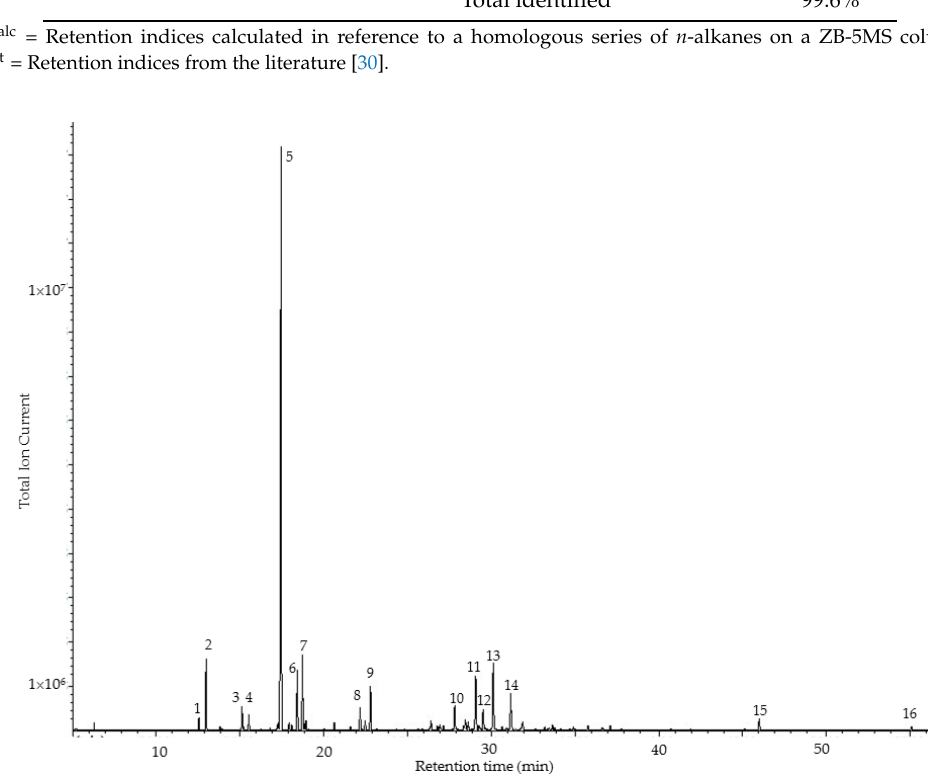
Figure 1. Gas chromatogram of the oleoresin essential oil of Protium amazonicum from Ecuador. 1, α- thujene; 2, α-pinene; 3, 3,7,7-trimethyl-1,3,5-cycloheptatriene; 4, β-pinene; 5, δ-3-carene; 6, p -cymene;